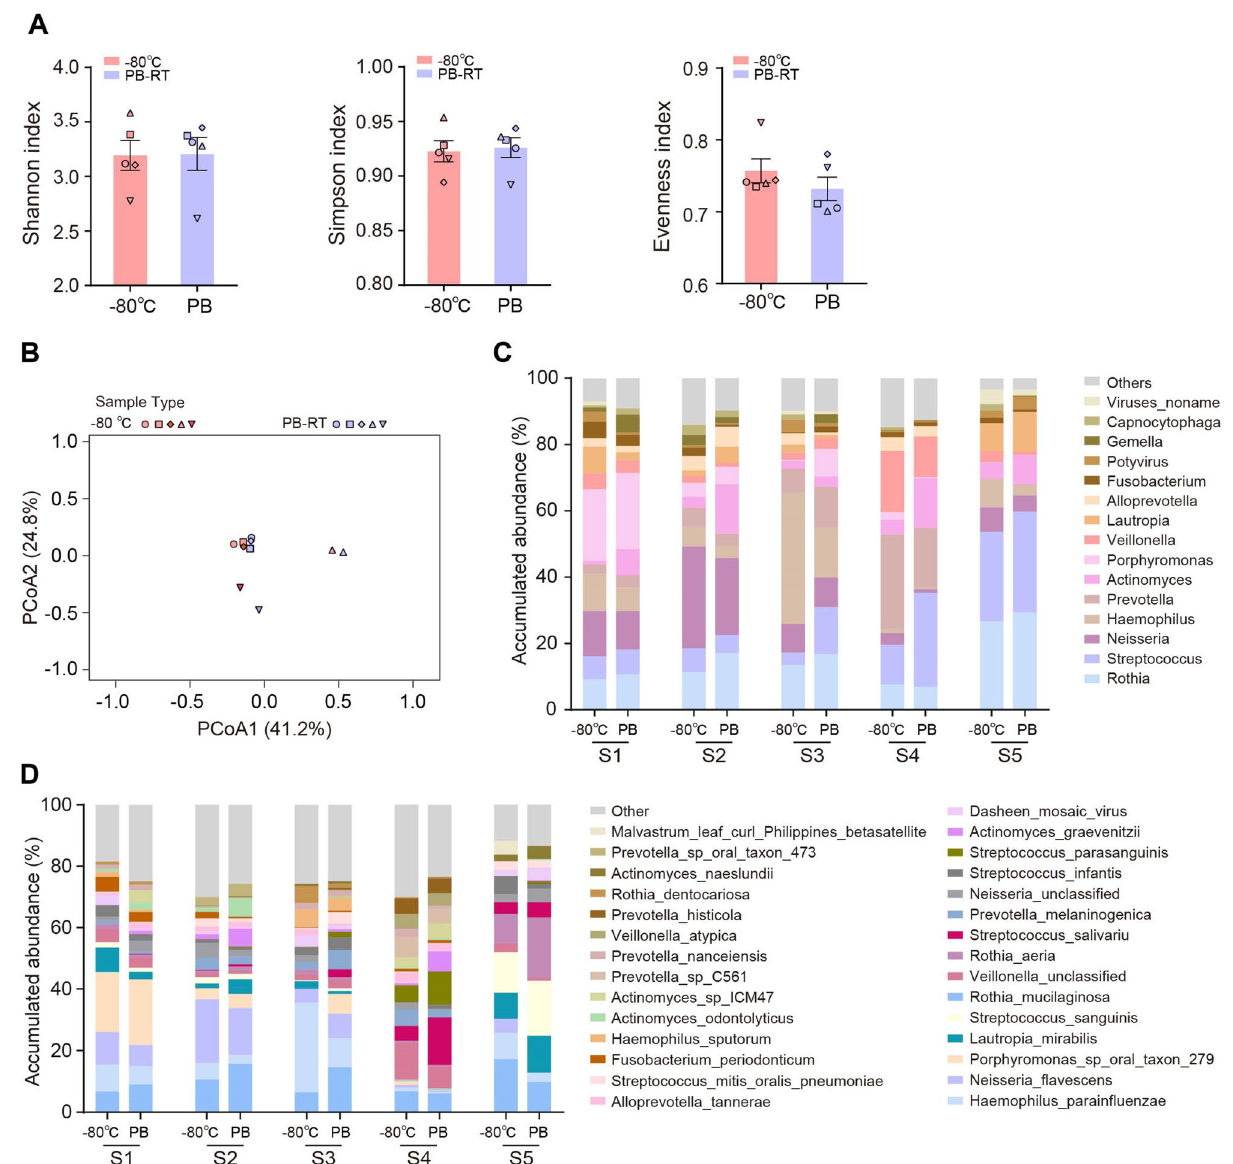
Figure 4. Stability analysis of human saliva samples preserved with PB buffer. ( A ) Shannon, Simpson and Evenness indices of saliva microbiota stored under − 80 °C or room temperature with PB buffer. ( B ) PCoA analysis of microbial communities. Compositional patterns of saliva microbiome at the genera ( C ) and species ( D ) level. N = 5